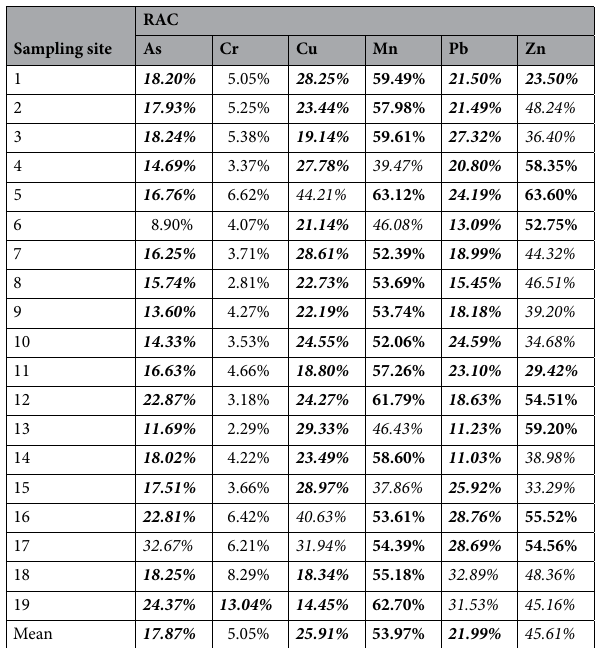
Table 6. RAC value of HMs in surface sediments. The bold font indicates: RAC > 50%, very high risk; italic indicates: RAC is 30–50%, high risk; bolditalic indicates: RAC is 10–30%, medium risk.